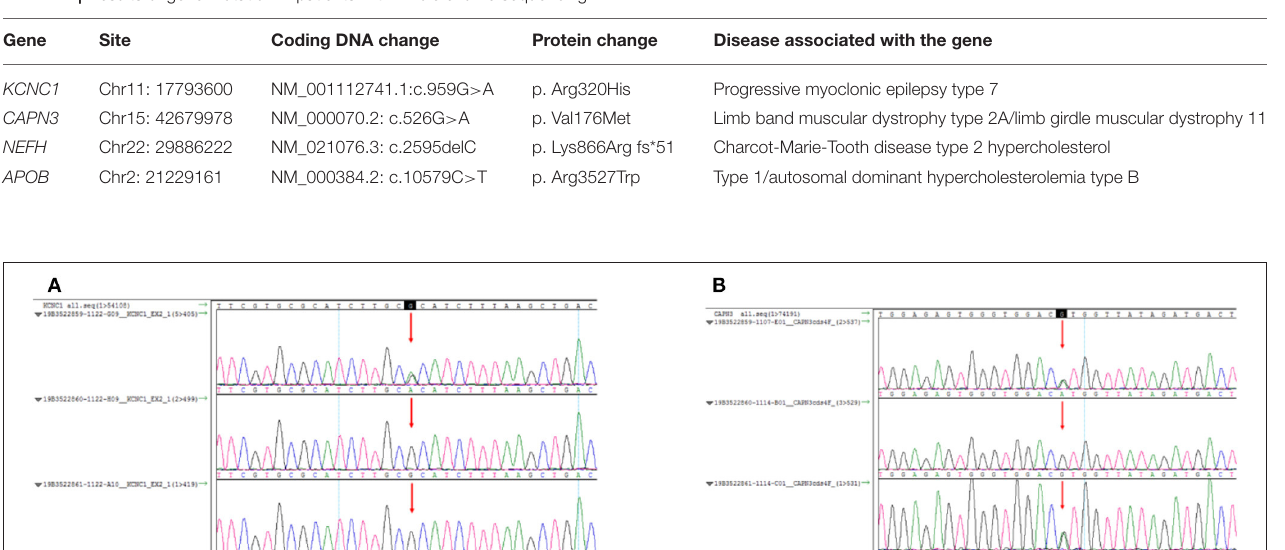
TABLE 1 | Results of gene mutation in patients with whole exome sequencing.